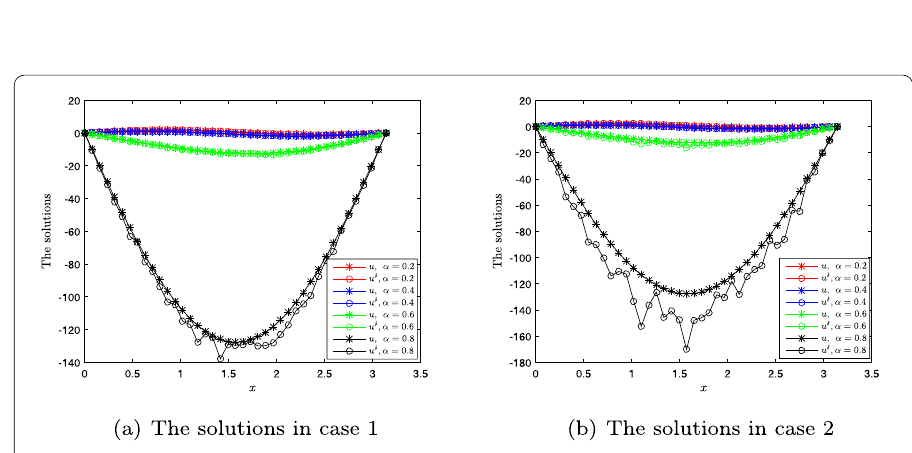
Figure 3 A comparison between the exact & regularized solutions of the proposed method (case 1) and according to [19] (case 2) at t = 0.1 for α ∈ { 0.2;0.4;0.6;0.8 } , δ = 0.01, N x = N t =